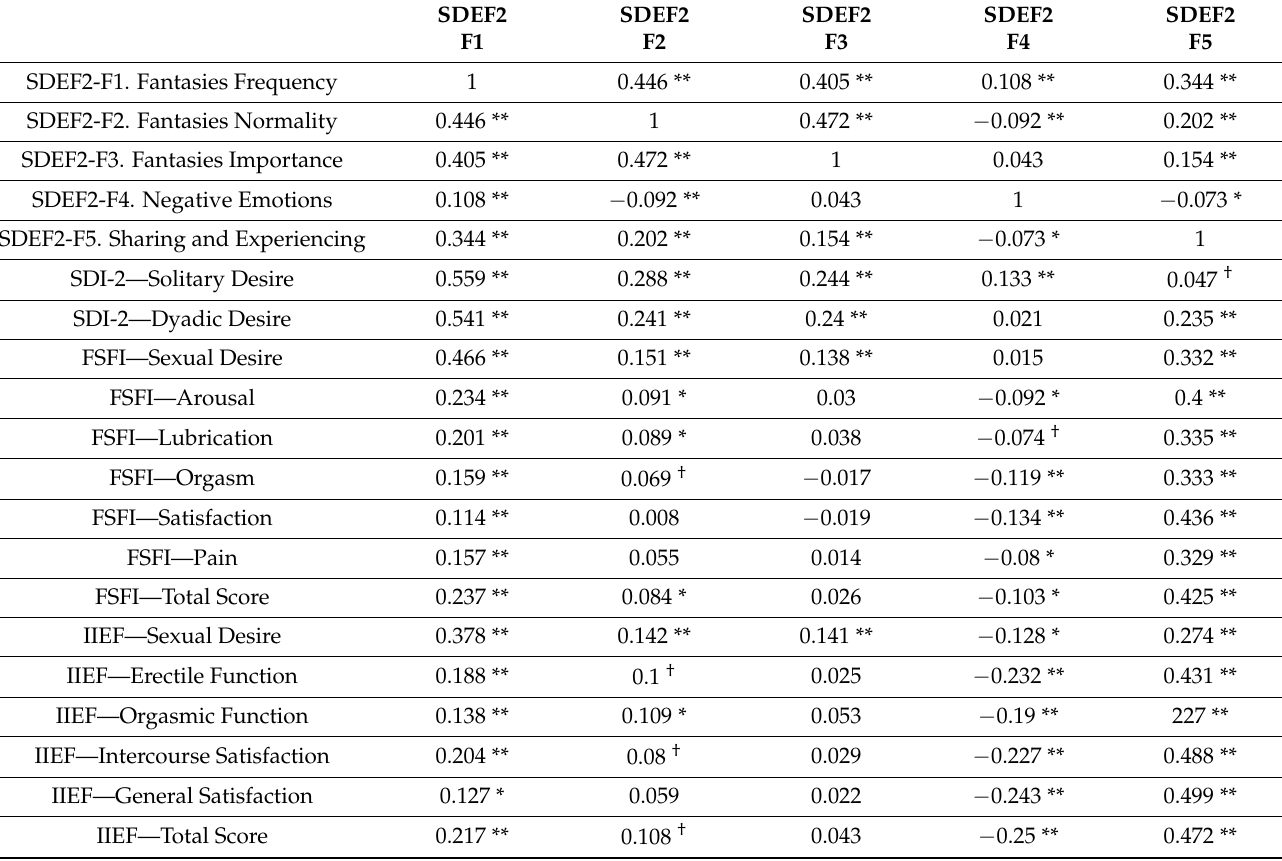
Table 3. Person’s correlation matrix between SDEF2 Factors, SDI-2, FSFI, and IIEF (n =